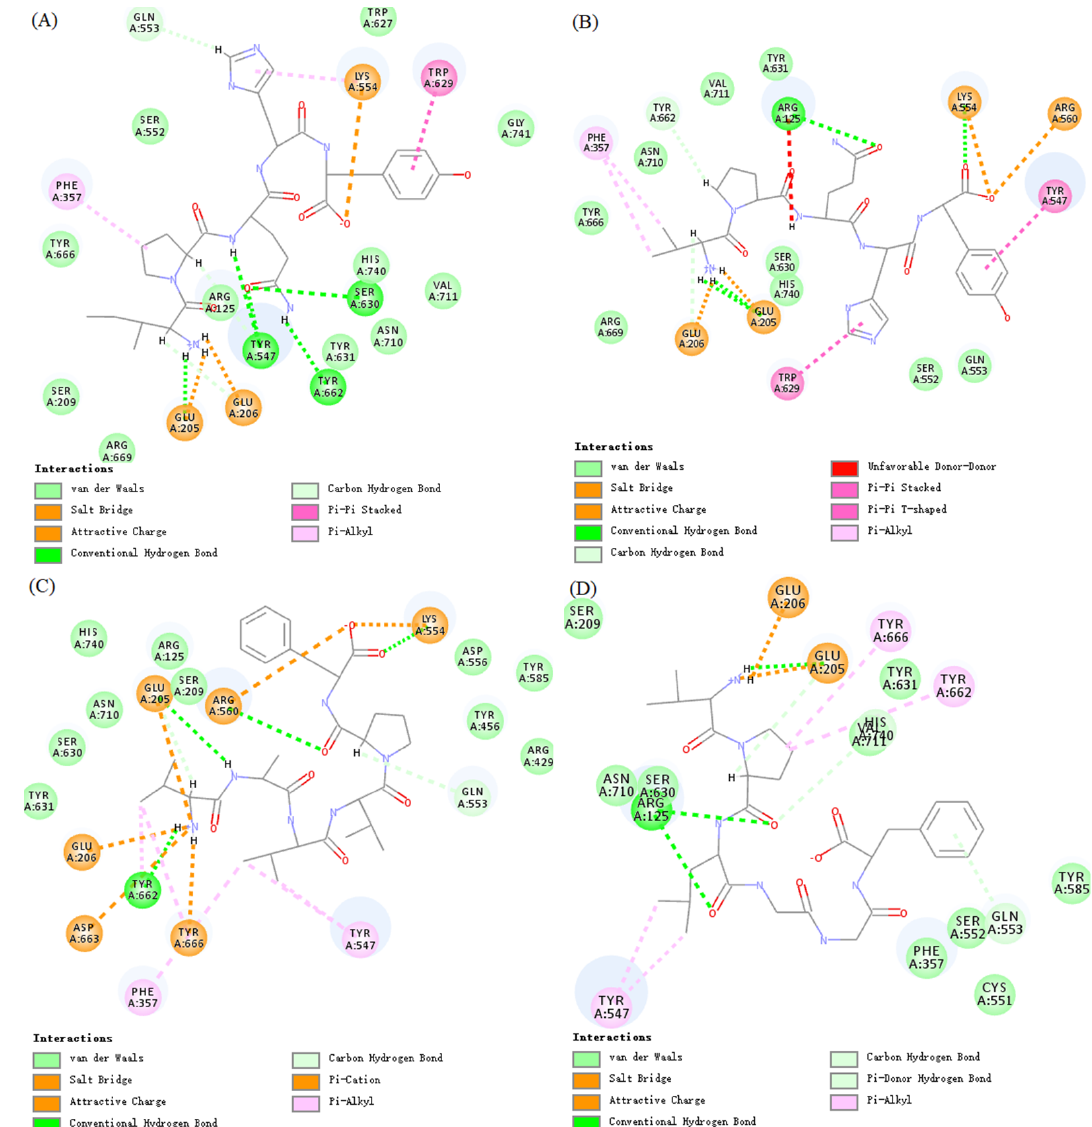
Figure 4. Molecular interactions between DPP-IV and peptides IPQHY ( A ), VPQHY ( B ), VAVVPF ( C ), and VPLGGF ( D ).